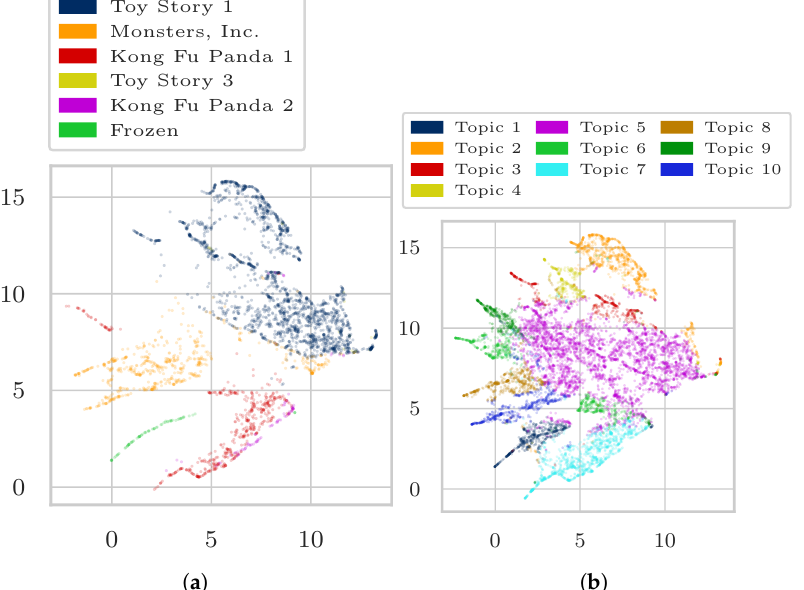
Figure A13. ( a ) 2-dimensional representation of word embeddings H colored by topic assignment. ( b ) 2-dimensional representation of word embeddings H colored by original review